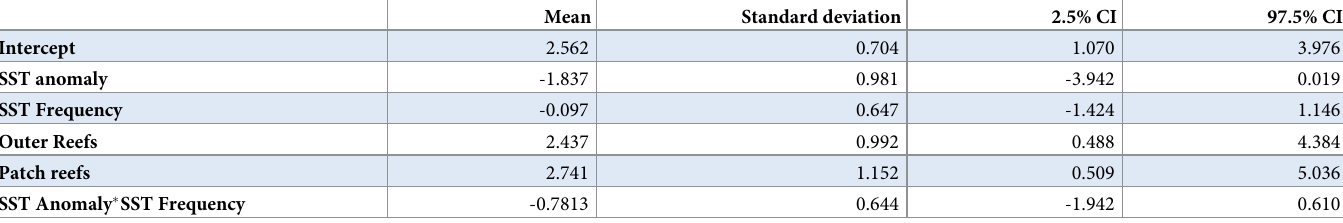
Where CI indicates credible intervals, SST is the sea-surface temperature, the Deviance Information Criterion (DIC) = 818.53, the Watanabe-Akaike information criterion (WAIC) = 819.31, the marginal log-Likelihood = -439.67, and the � indicates